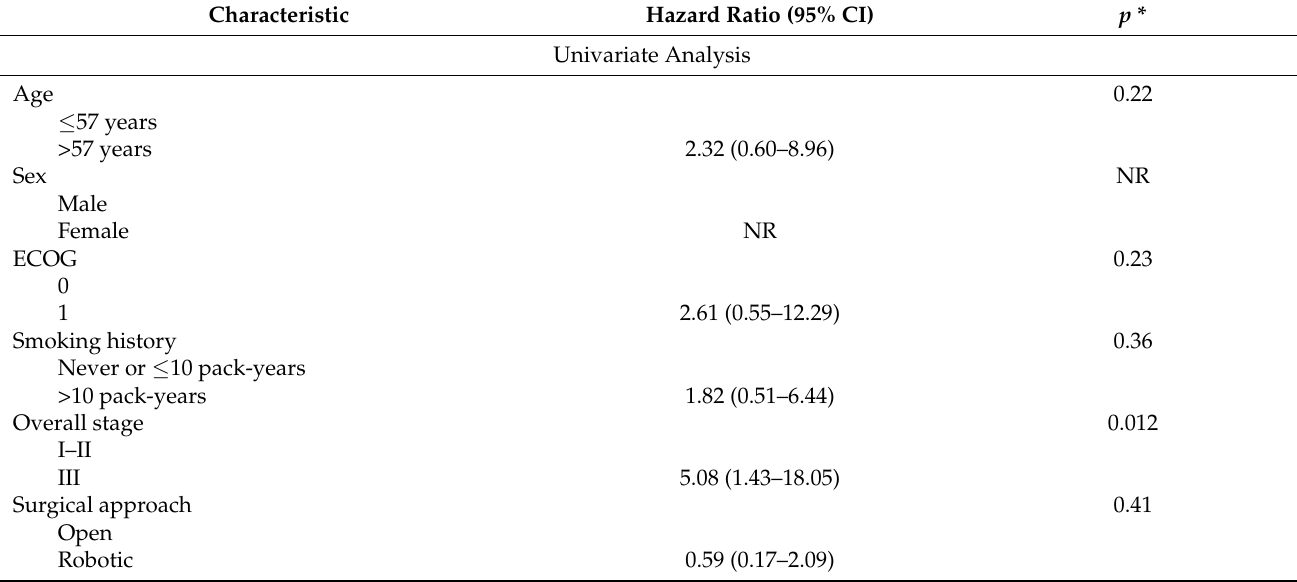
Table 5. Univariate and multivariate analyses for progression-free survival for patients who received surgery as the primary